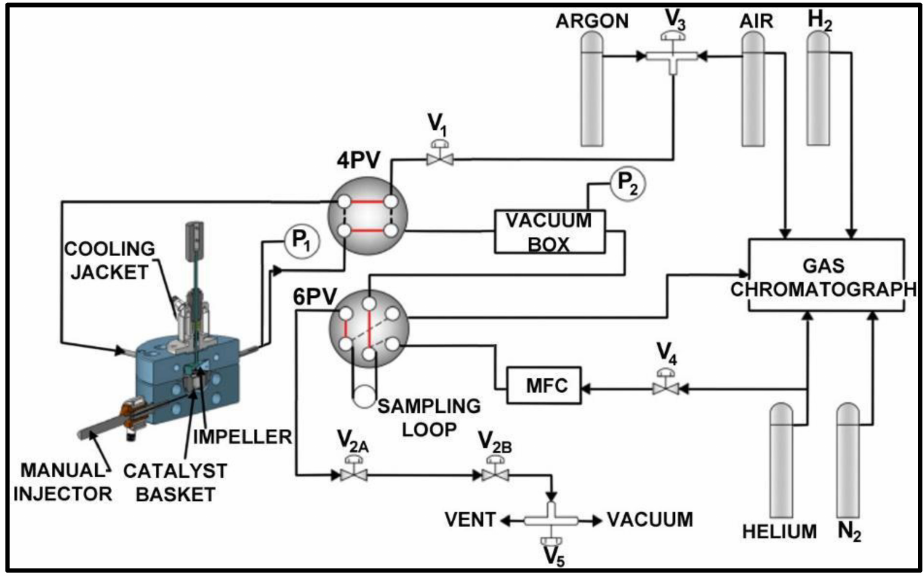
Figure 9. Schematic diagram of the CREC Riser Simulator experimental setup